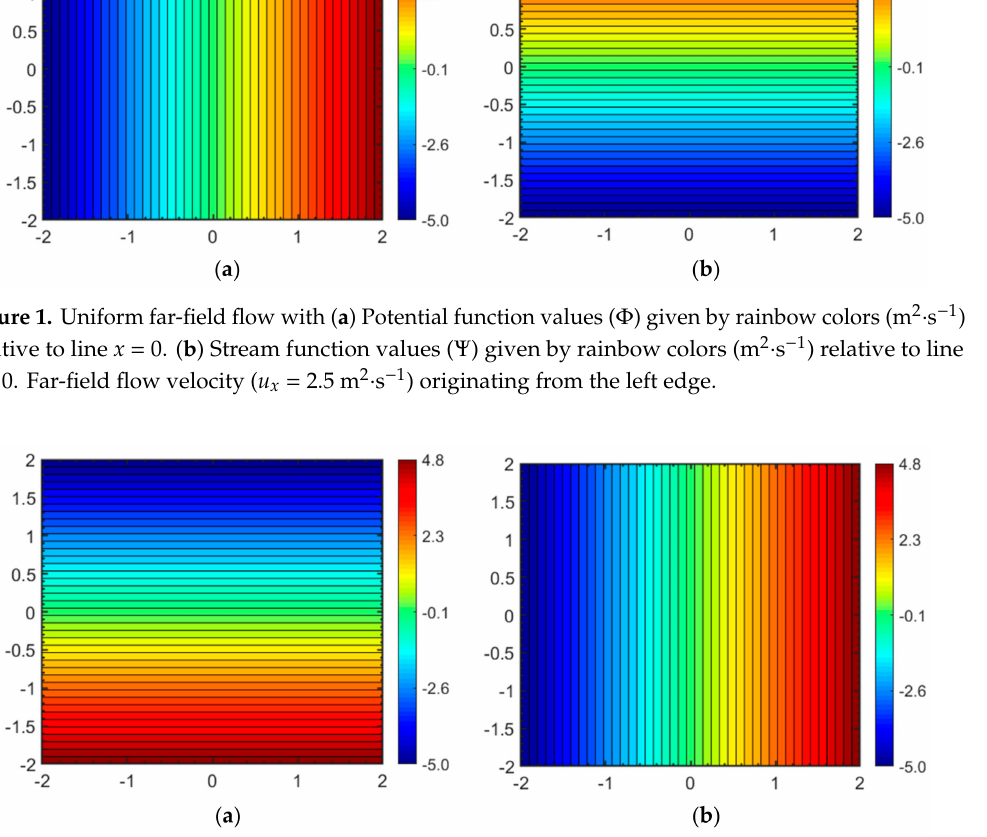
Figure 2. Potential function ( a ) and stream function ( b ). Far-field flow velocity ( u y ) = 2.5 m · s − 1 originating from the top